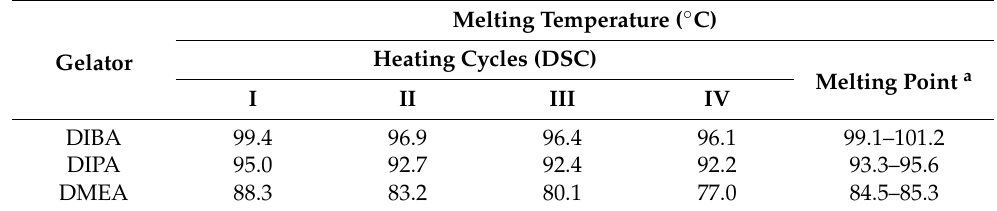
Table 4. Melting temperatures (°C) of neat gelators at maximum heat flows as determined by DSC (4 cycles) and on the hot stage of a microscope.